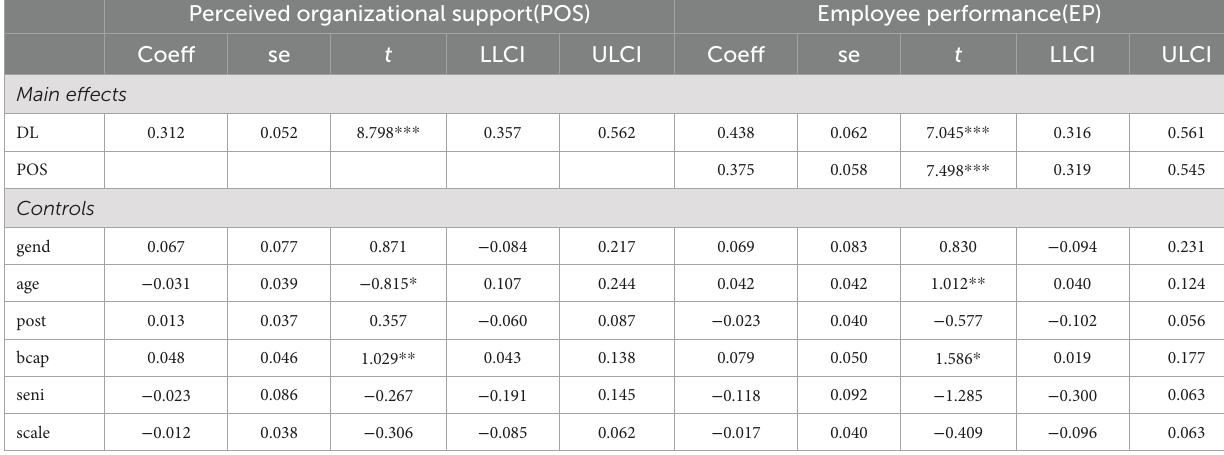
TABLE 3 Bootstrapping results for mediation effect. Perceived organizational